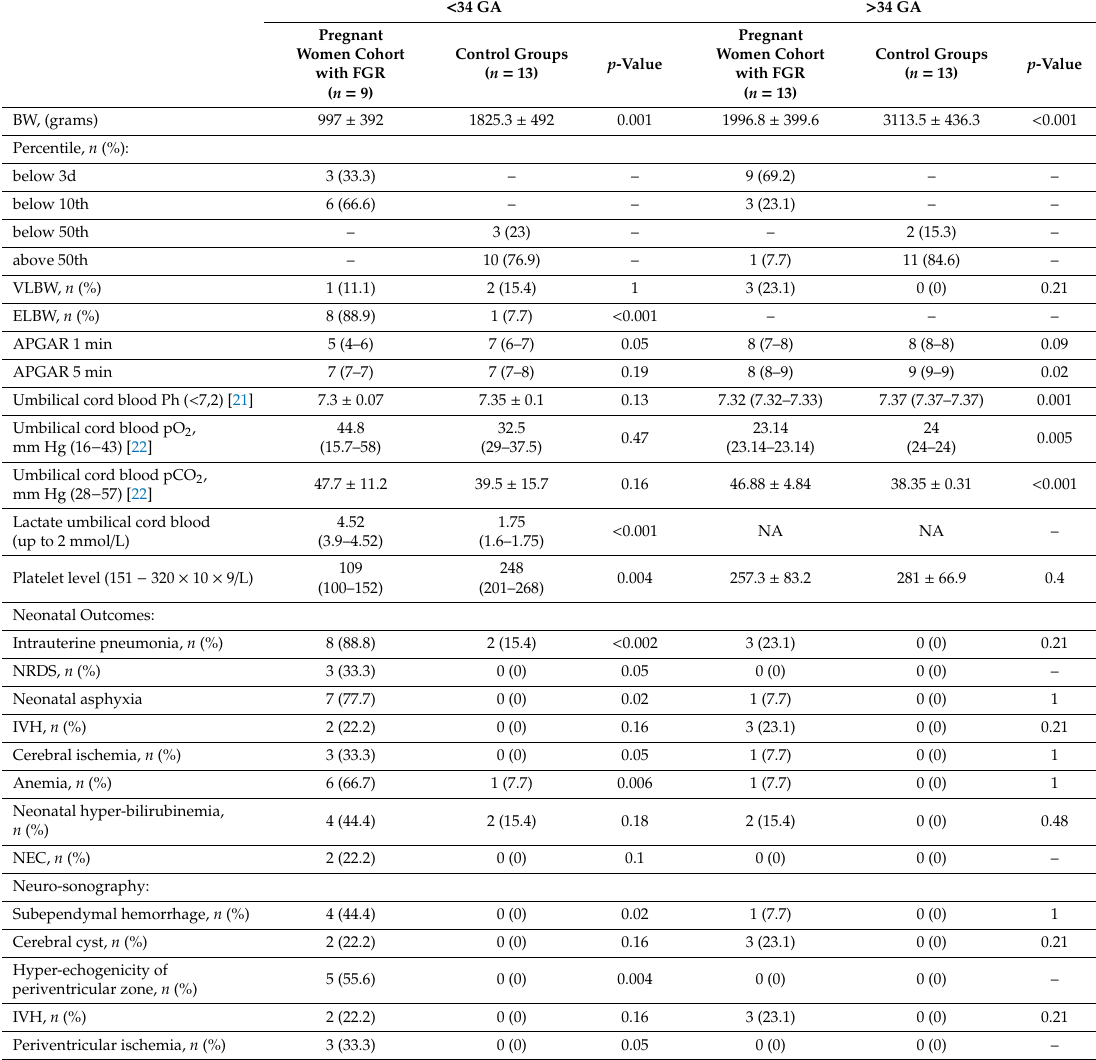
Table 2. Clinical state assessment of newborns with FGR and neonatal